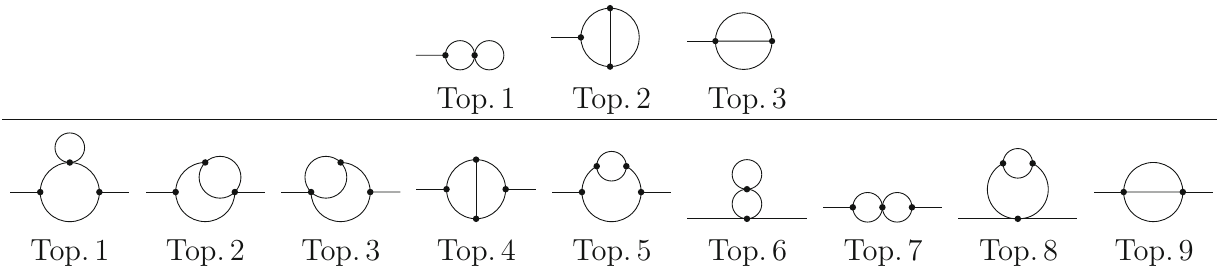
U , U , M , V , X , Z , W , S respectively (topologies 2 and 3 are equivalent for identical incoming/outgoing